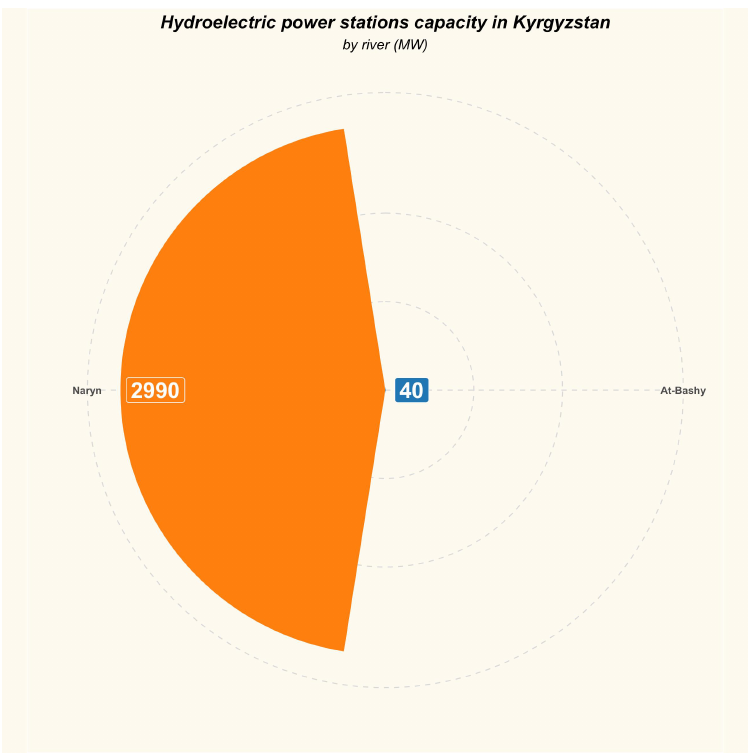
Figure 12. Hydroelectric power station capacities in Kyrgyzstan by river. Data source: Elektricheskie Stantsii company website, http://www.energo-es.kg, accessed on 16 July